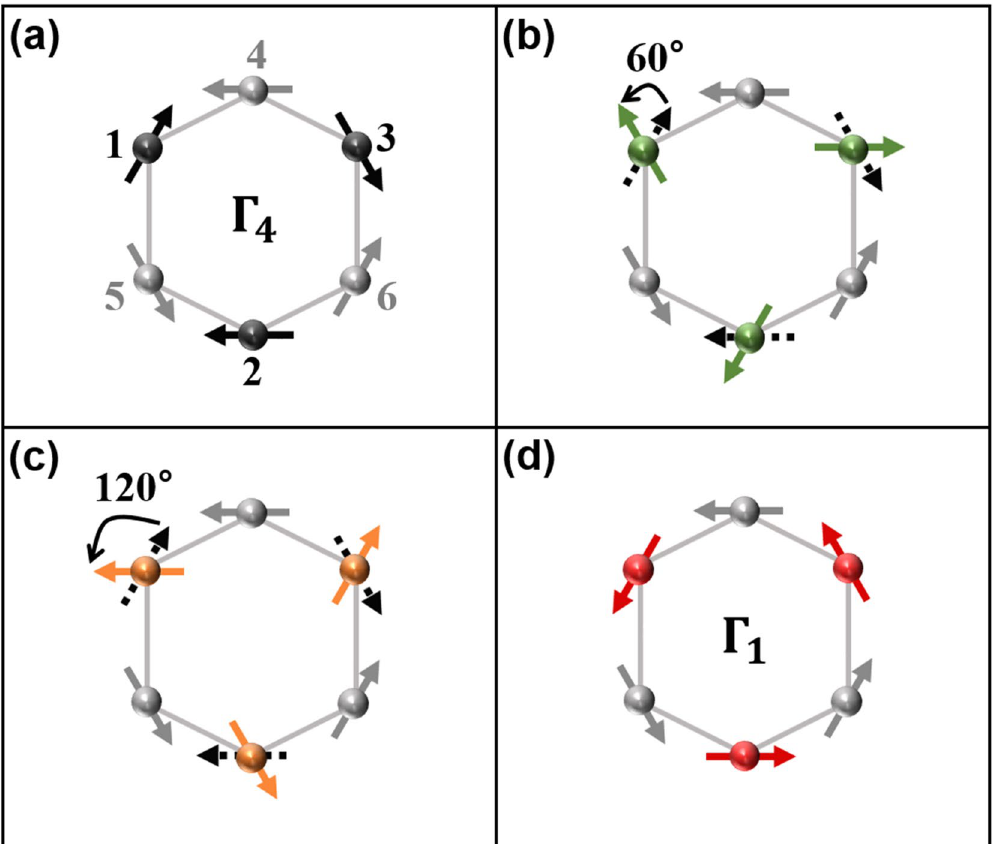
Figure 2. Several AFM spin configurations of hexagonal LuMnO 3 single crystal. Mn-ions are indicated by solid spheres: gray spheres (number 4, 5, 6) are located in the z = c 2 plane and black or colored ones (number 1, 2, 3) are in the z = 0 plane. Each arrow overlapped with the sphere expresses the spin direction of a Mn 3+ -ion (S = 2). We assume that colored spheres only are excited by the incident light. ( a ) The Ŵ 4 spin structure in the ground state. ( b ) Three spins (1, 2, 3) rotated counterclockwise by 60° (green arrows), or ( c ) by 120° (orange arrows). ( d ) Three spins (1, 2, 3) are flipped from the Ŵ 4 structure, resulting in the Ŵ 1 spin structure locally (red